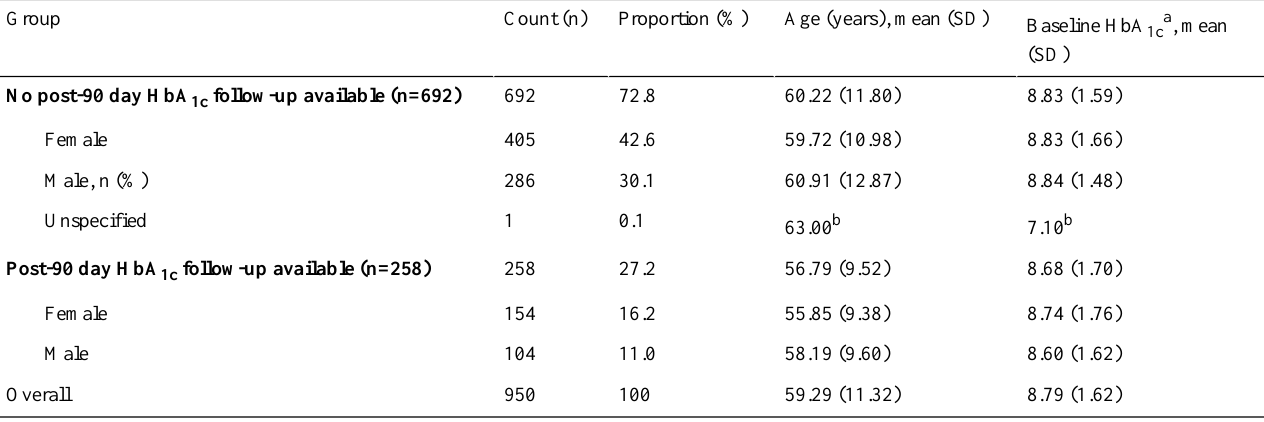
Table 1. Demographic characteristics of the study cohort